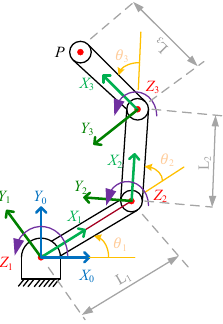
Figure 12. D-H coordinate system of the single- fi nger model.